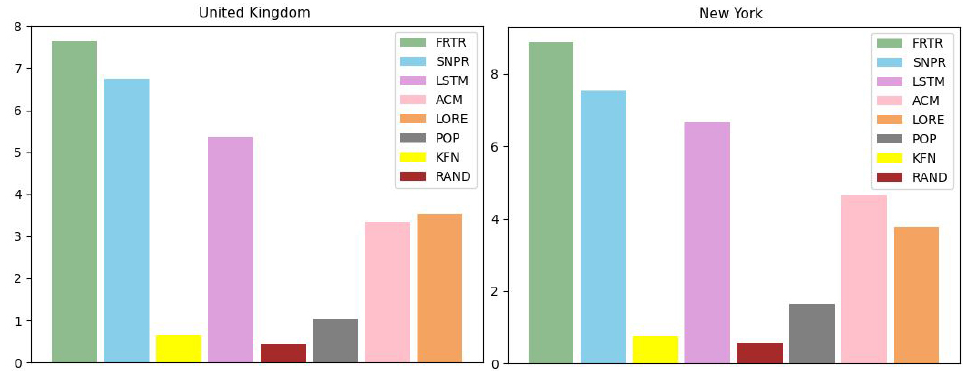
Figure 3. Total accuracy of the United Kingdom and New York.